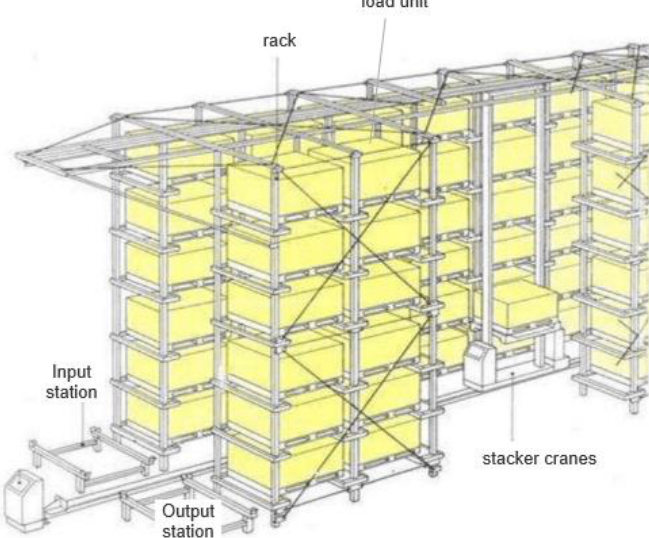
Figure 1. An example of Miniload AS/RSs.